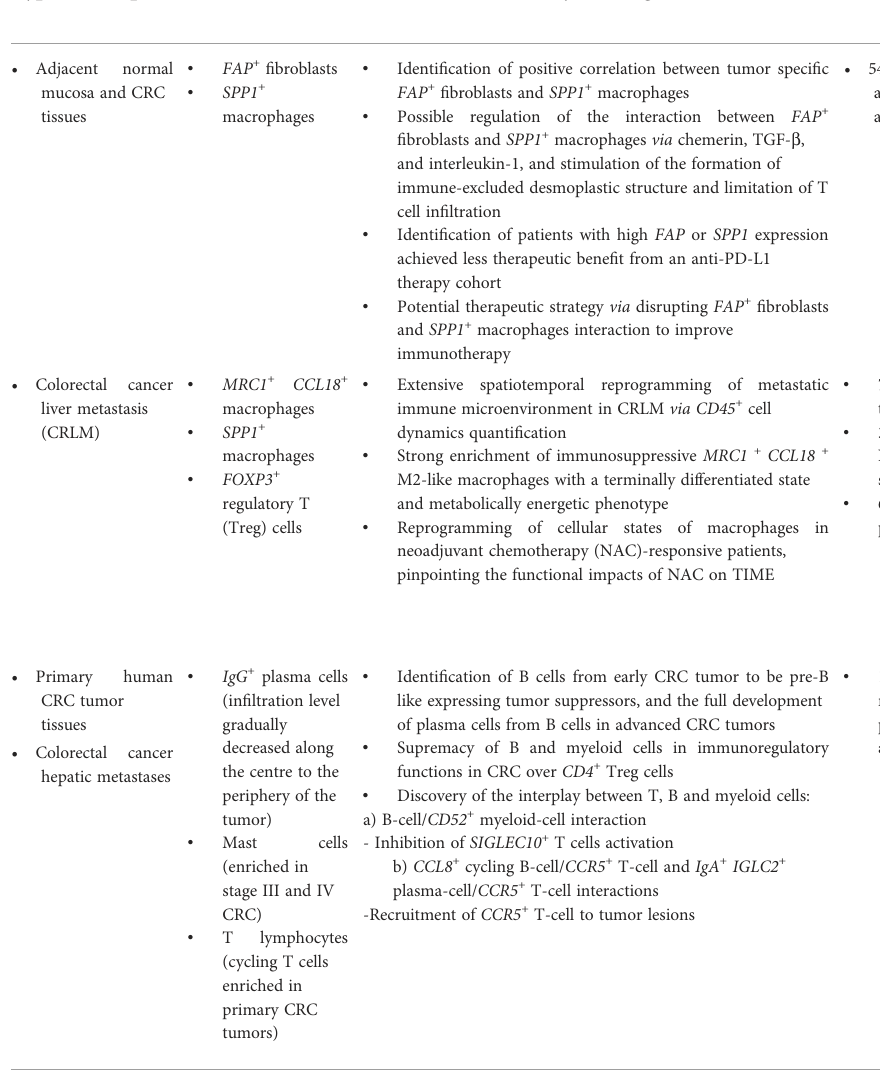
TABLE 1 The summary of key discoveries on the single-cell transcriptional CRC immune landscape. Type of Sample Key